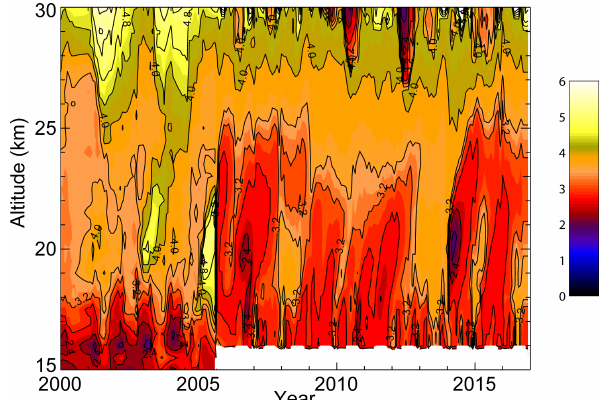
Figure 14. Final GloSSAC distribution for 525nm extinction at 21km using the same contouring intervals and coloring as in Fig. 2.